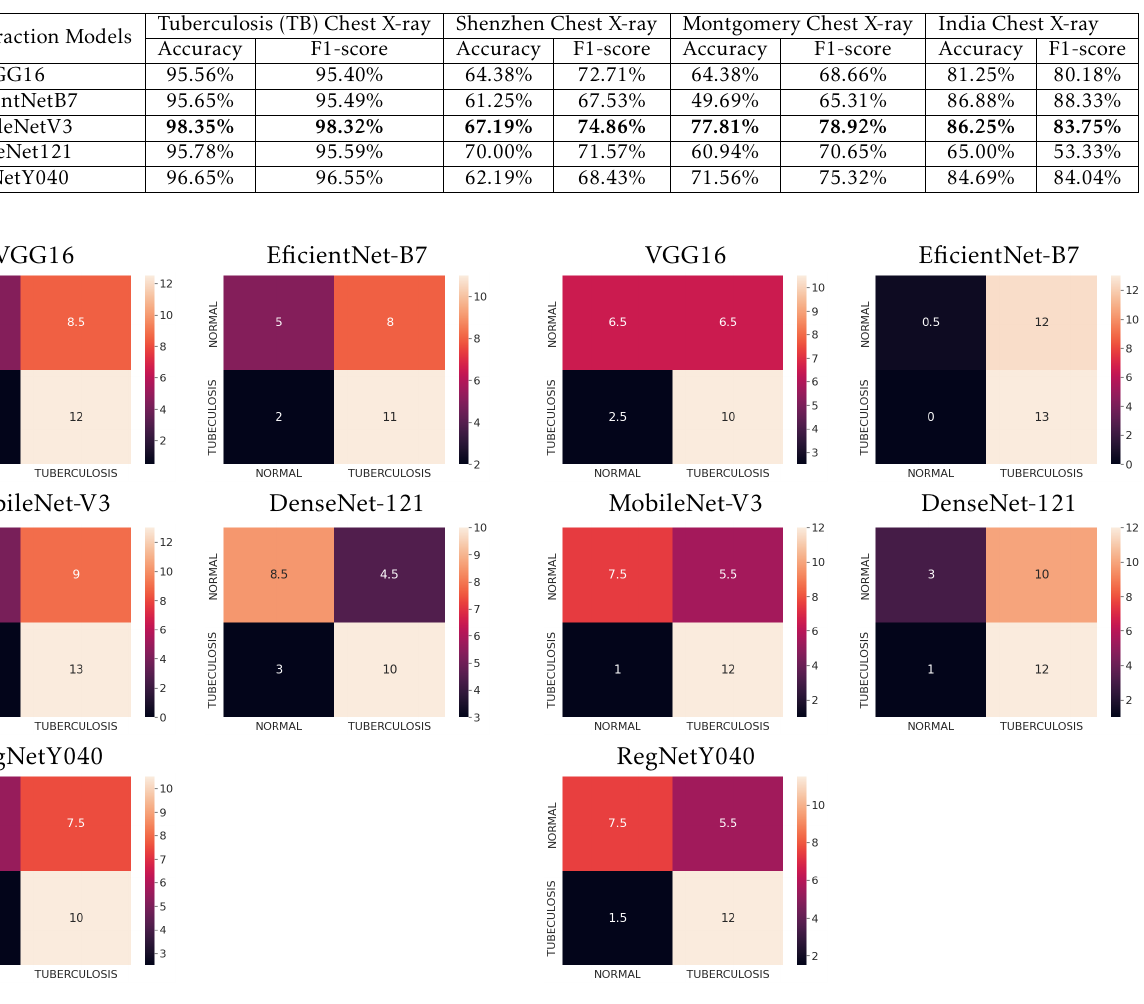
Figure 11. Confusion matrices for models applying to Shenzhen Chest X-ray Set - MobileNet-V3 provides the second good results with True Positive and False Negative images detected are high - 4 and 13 correspondingly